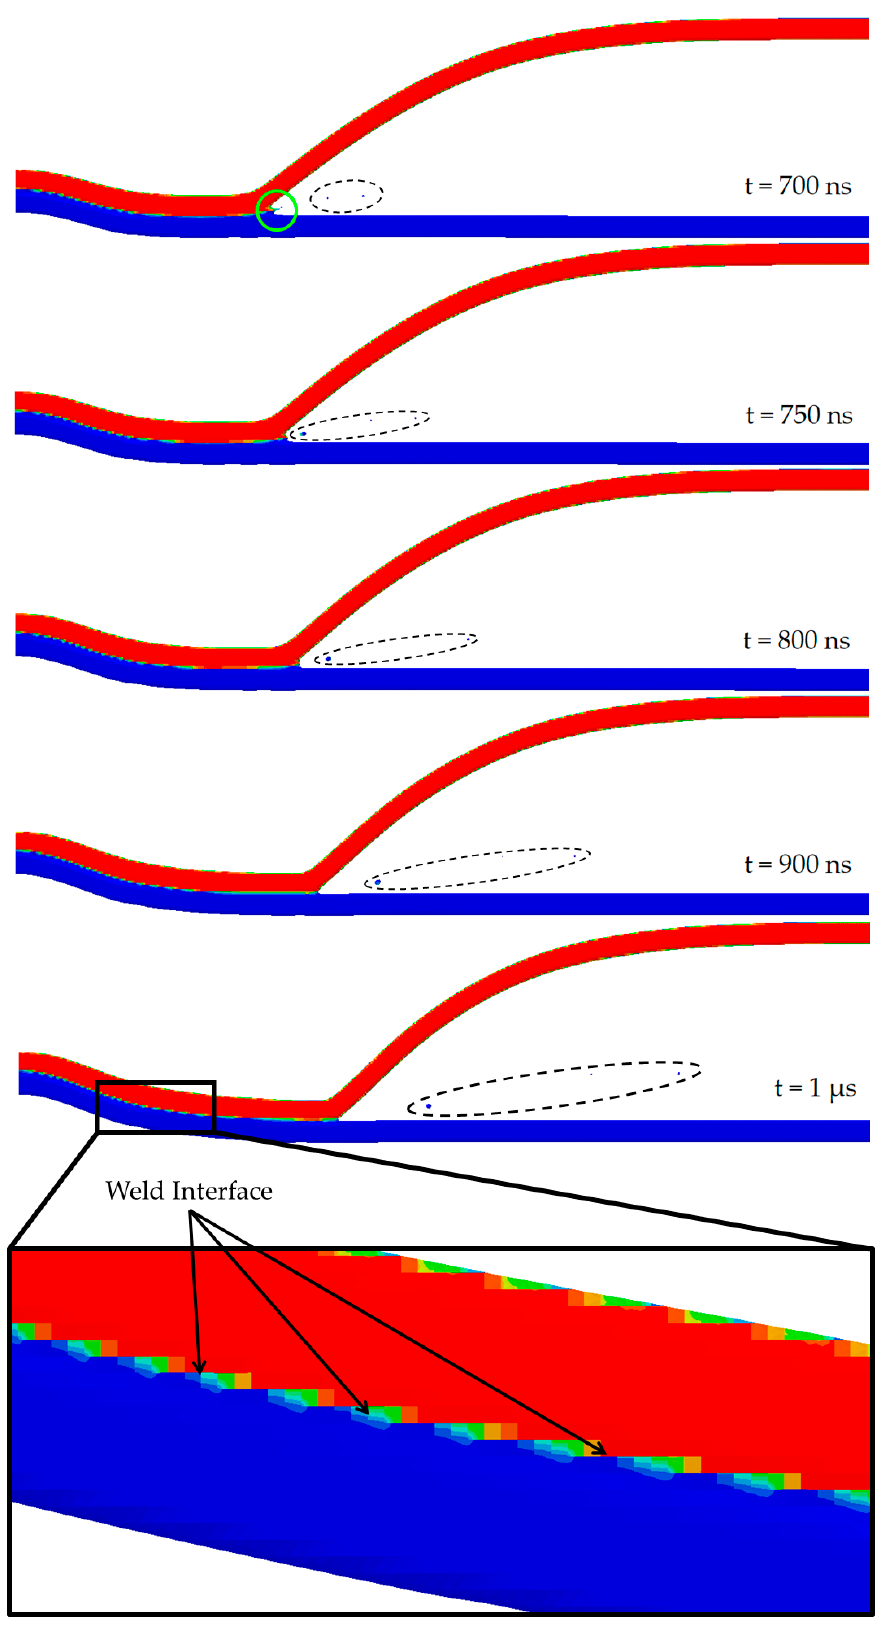
Figure 19. Jetting phenomenon at different times and interlocking of the foils along the weld interface in Eulerian simulation of the LIW process.